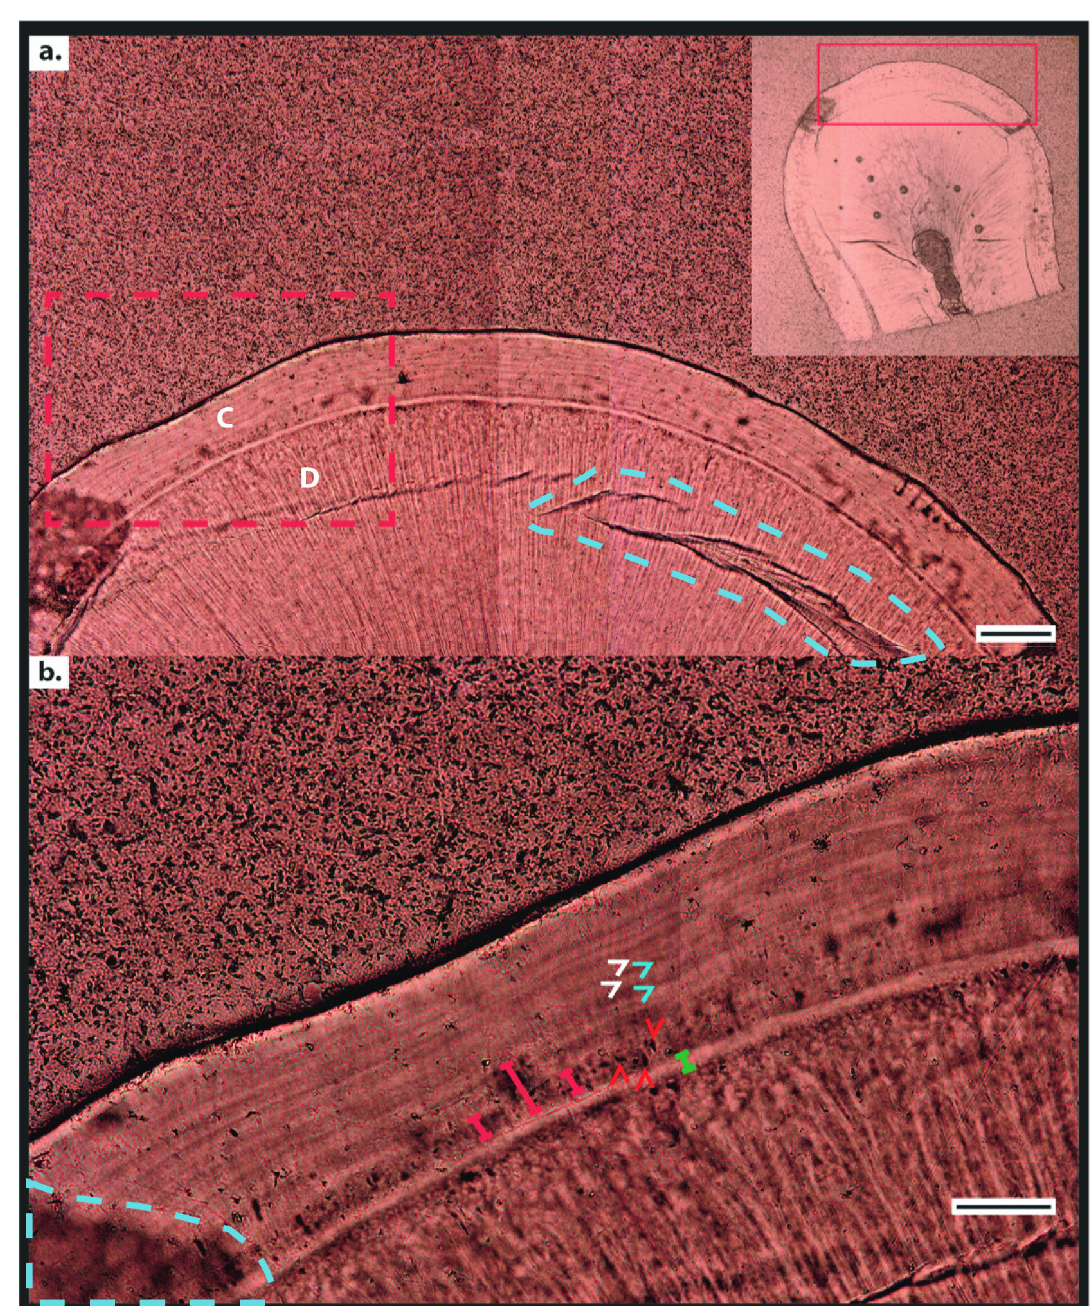
Fig 1. Histological data of rhesus macaque ( Macaca mulatta ) cementum in the permanent lower first molar tooth. ( a ) 70 μ m-thick transverse reflected light digital micrograph of the cementum tissue from the coronal third of the tooth root at 20 × magnification. Cementum (C) is defined as the tissue wrapping around the circumference of the dentine (D), comprising a series of circumferential increments. Blue dashed line highlights a surface scratch created during the thin-sectioning process. ( b ) Detail marked by red dashed box in ( a ) displaying cementum increments in acellular extrinsic fibre cementum (AEFC), and cellular voids left by cementoblasts in cellular intrinsic fibre cementum (CIFC) under higher resolution (50 × magnification). White arrowheads highlight ‘light’ increments, blue arrows highlight ‘dark’ increments, and red arrows highlight cementoblasts. Red bracketed lines highlight intrinsic fibre cementum (CIFC). Green bracketed line highlights the hyaline layer of Hopewell-Smith, demarcating the cemento-dentine boundary. Scale bar in ( a ) represents 100 μ m. Scale bar in ( b ) represents 30 μ